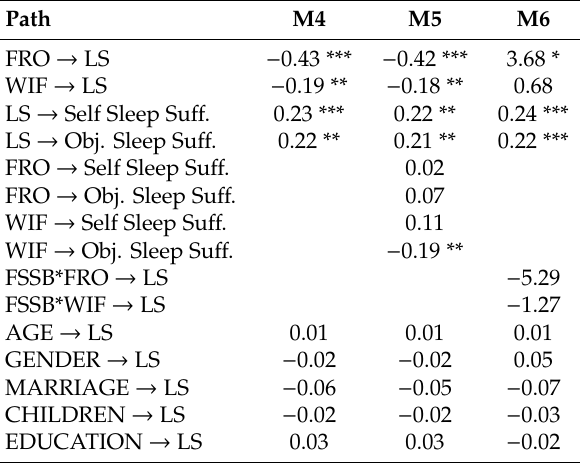
Table 4. Results of path coe ffi cients.